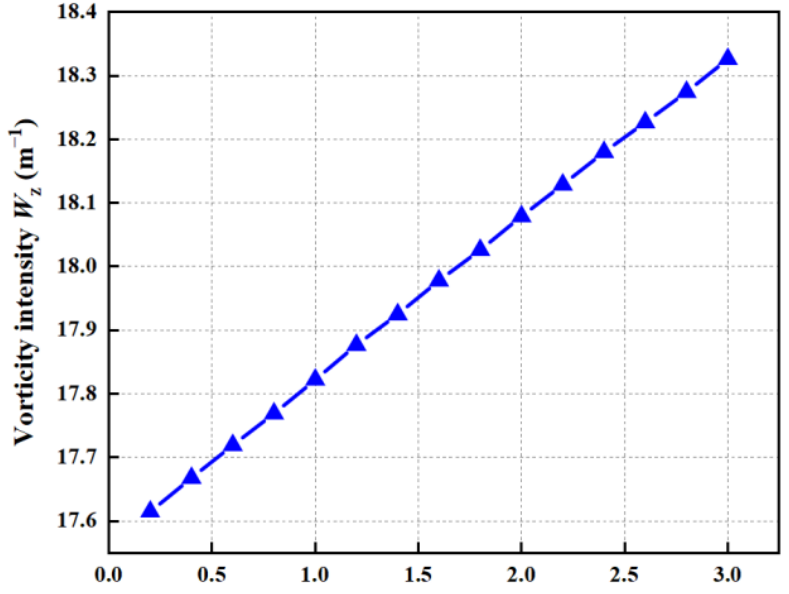
Figure 14. Vorticity intensity of V1 vortex core in 3 impeller rotation periods. To analyze the vorticity field distribution of RAV along the axial direction, five sections (S1~S5) are taken along the axial direction in the closed inlet tank. As shown in Figure 15, S1 is the roof’s surface, S3 is the center surface of the impeller, and S5 is the inlet surface of the bell mouth. As shown in Figure 16, take the vorticity field distribution of section S1~S5 at time T. It can be seen from the figure that with the increase of the axial distance from the roof, the area of V1 gradually increases and the vorticity intensity at the vortex core decreases. In addition, the position of V1 is not attached to the wall of the pump device. In sections S2–S4, the vortex V1 deviates from the water pump device, and in section S5, V1 is attached to the bell mouth of the pump device. The position of V2 gradually approaches the bell mouth with the increase of axial distance. In section S5, the bottom of V1 is attached to the bell mouth. The numerical simulation results are consistent with the experimental phenomena.